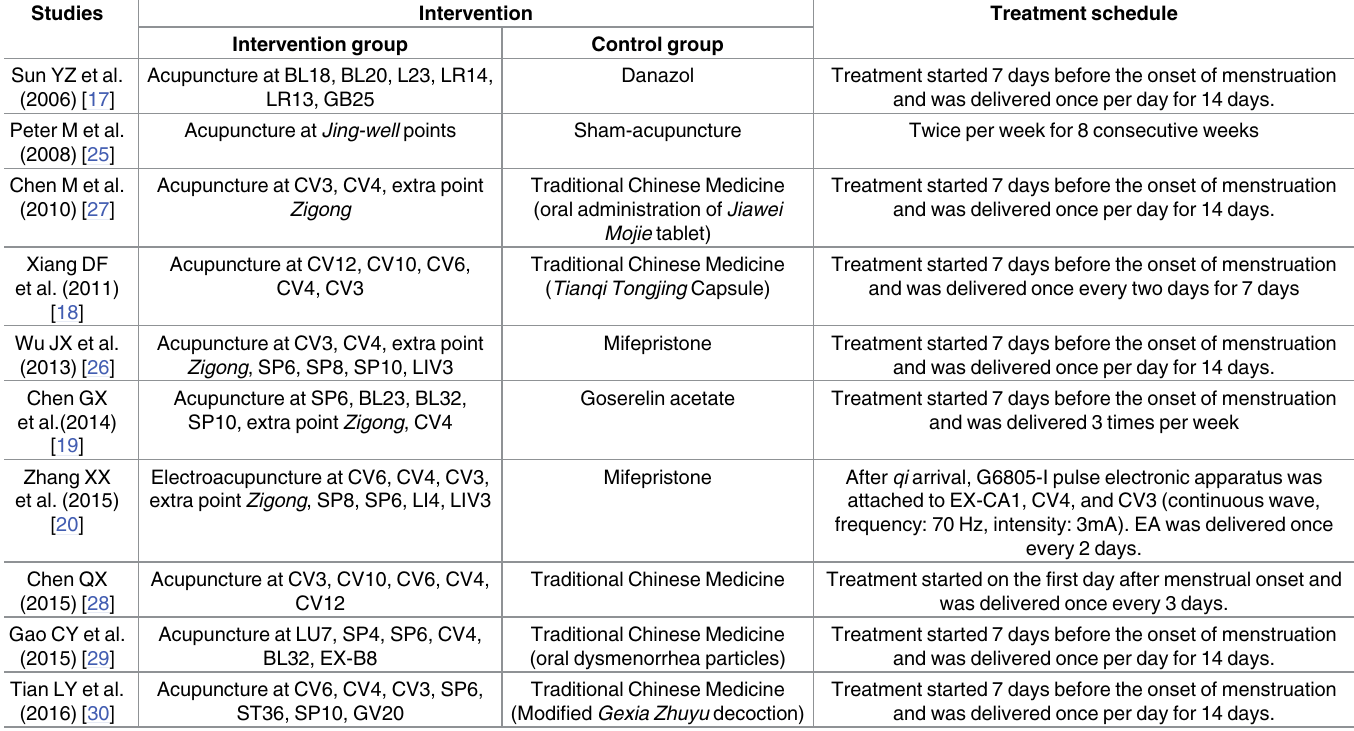
Table 2. Interventions of the 10 trials identified in the literature